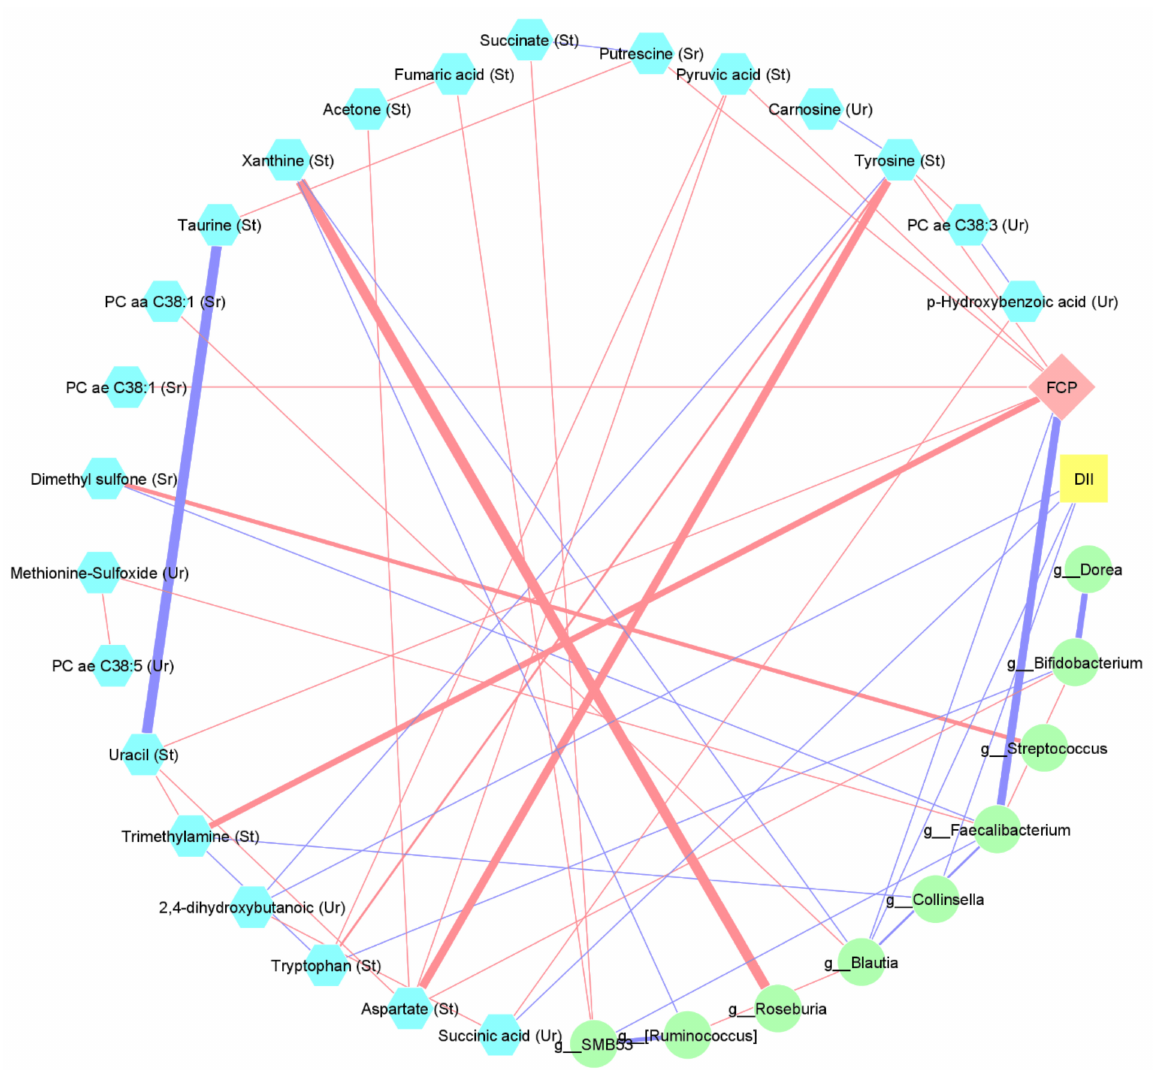
Figure 6. Correlation between changes in dietary inflammatory index (DII) score, fecal calprotectin (FCP), metabolites (urine: Ur, stool: St, and serum: r), and gut bacterial composition (genus level) from baseline to last visit (time of relapse or month 6). The statistically significant correlations were filtered using |Spearman’s rank correlation| >0.3, and subsequently, a correlation network was built. Only metabolites and bacteria that were correlated with either DII or FCP are shown. Blue lines represent negative correlations, and red lines represent positive